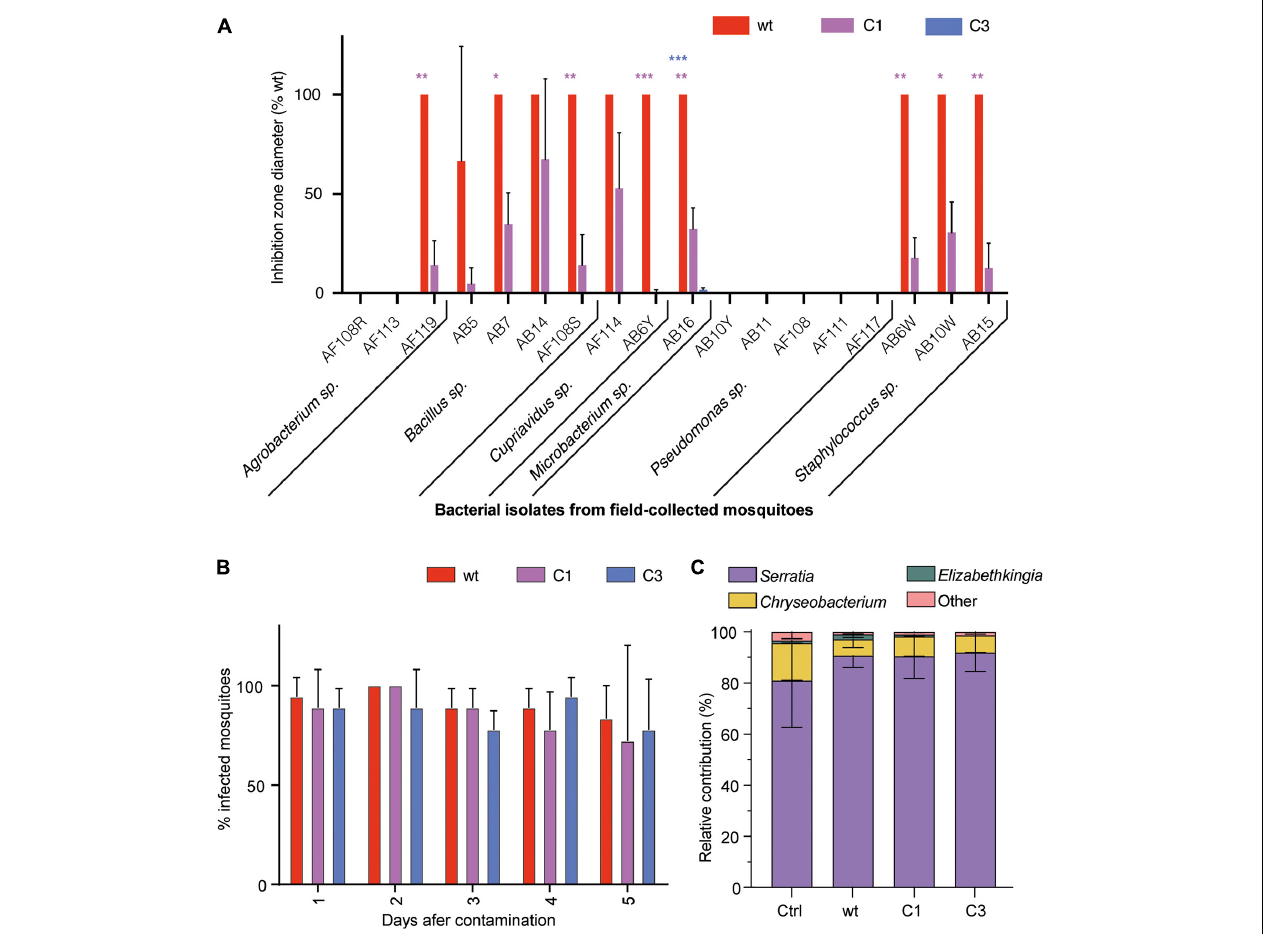
FIGURE 2 | Interaction of S. marcescens VA with the mosquito microbiota. (A) Inhibition zone diameter of the three strains on 18 bacterial strains isolated from the gut of field-collected mosquitoes. (B) Colonization success showed as the proportion of infected mosquitoes 1–5 days after feeding with a contaminated sugar solution (OD 600 nm = 1). (C) Relative contribution of the main bacterial genera found by high-throughput sequencing of 16S in mosquito guts 24 h after oral infection. Data show the average ± SEM of three independent replicates. * p < 0.05; ** p < 0.01; *** p <